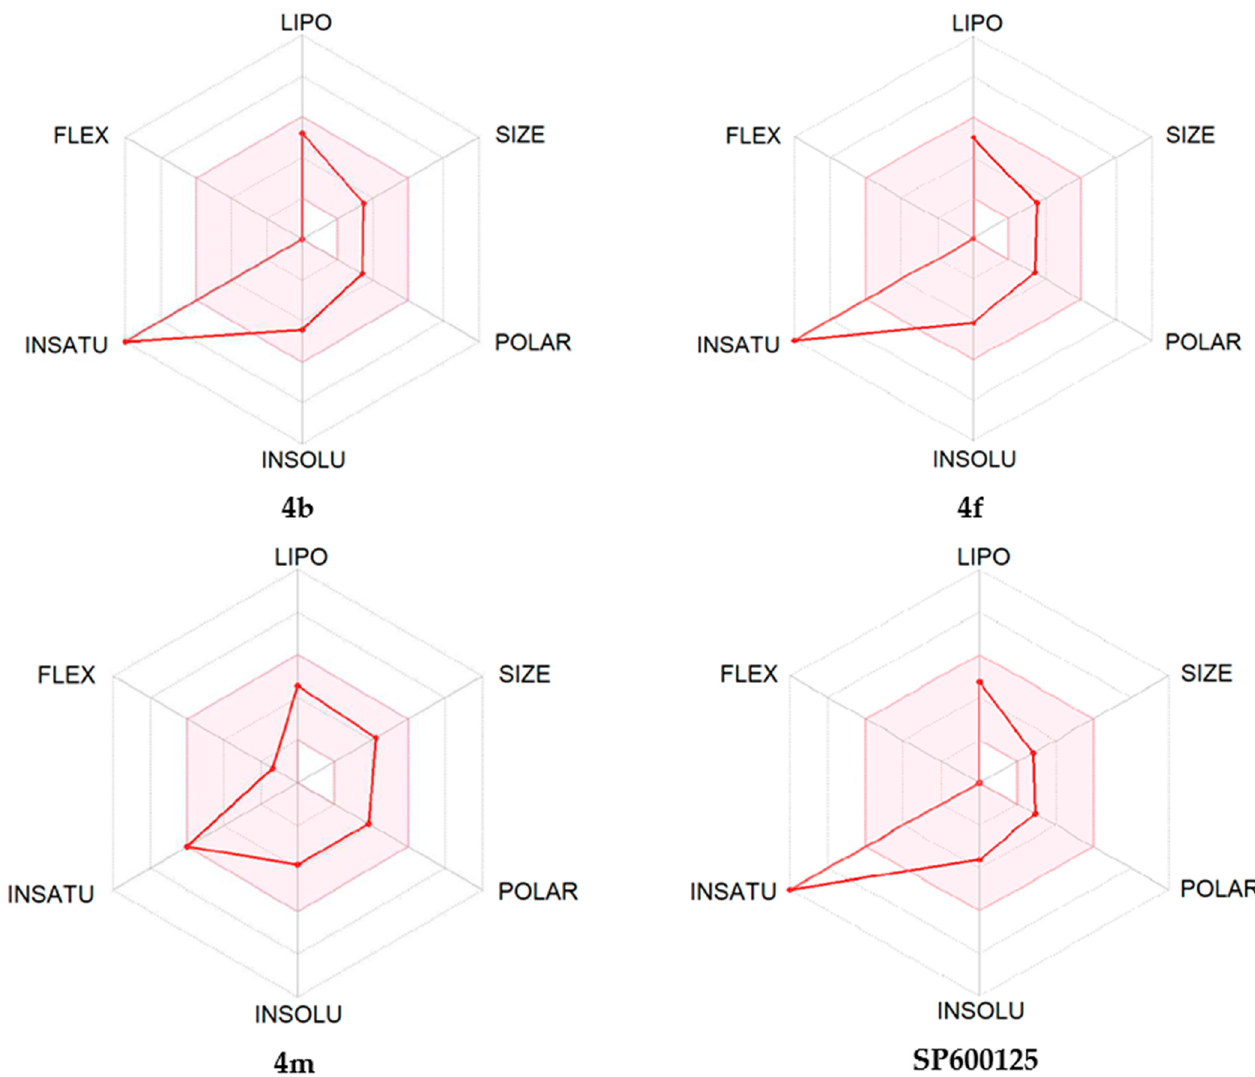
Figure 5. Bioavailability radar plots for compounds 4b , 4f , 4m , and SP600125 . The plots depict LIPO (lipophilicity), SIZE (molecular weight), POLAR (polarity), INSOLU (insolubility), INSATU (unsaturation), and FLEX (rotatable bond flexibility) parameters.